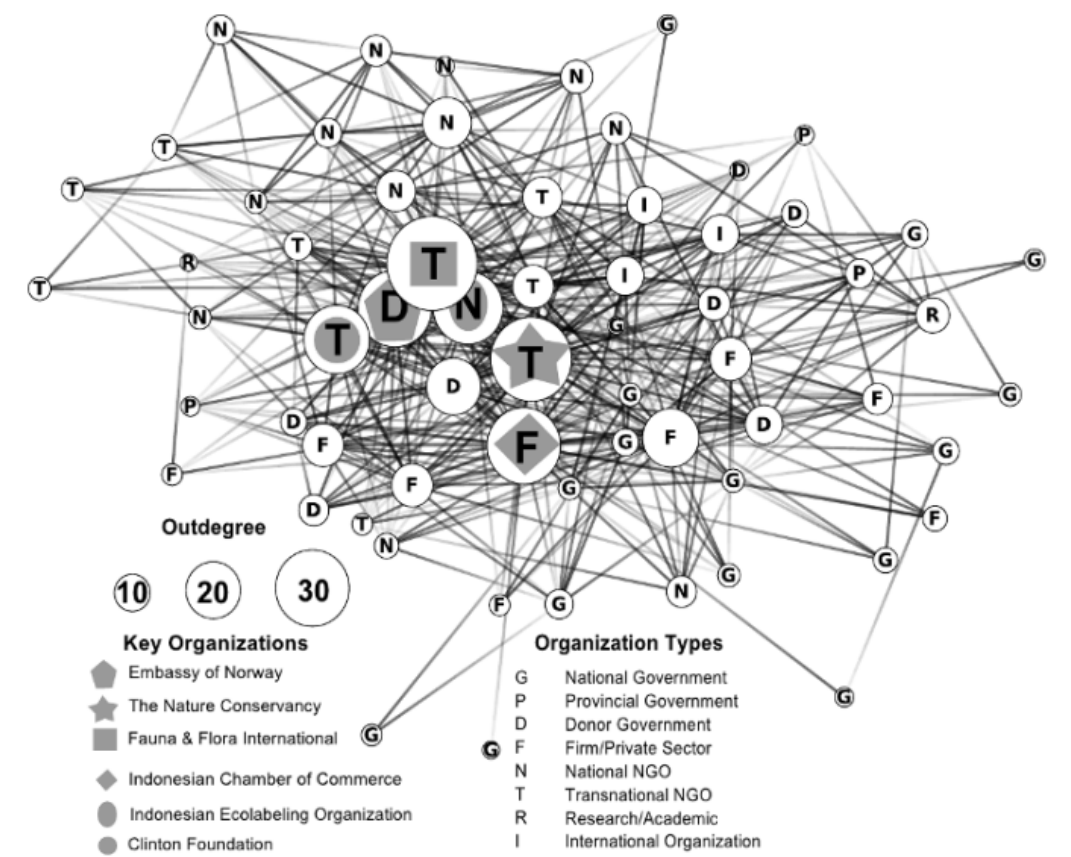
Fig. 1 . Directed network of information exchange between actors in the REDD+ policy arena in Indonesia